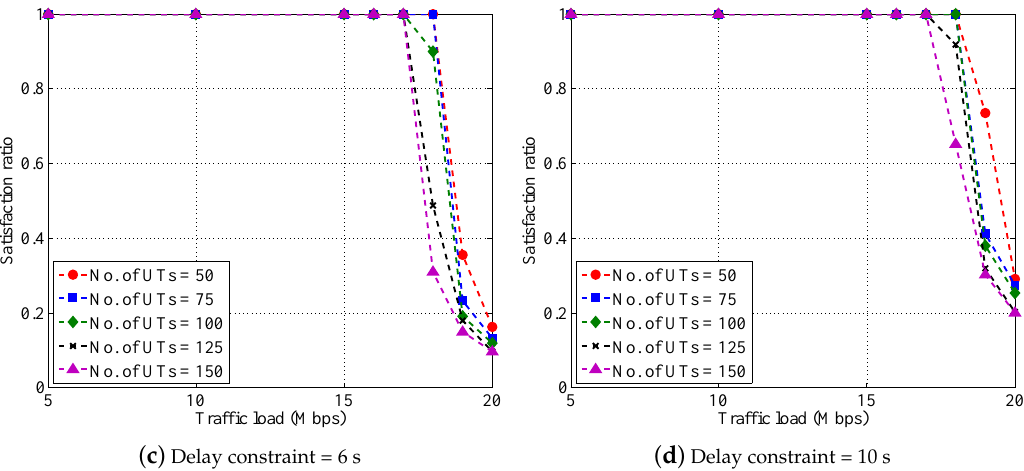
Figure 14. The satisfaction ratio when the spectral efficiency is 3 bps/Hz when the traffic load varies from 5–20 Mbps and the number of UTs varies from 50–150 (VBDC).